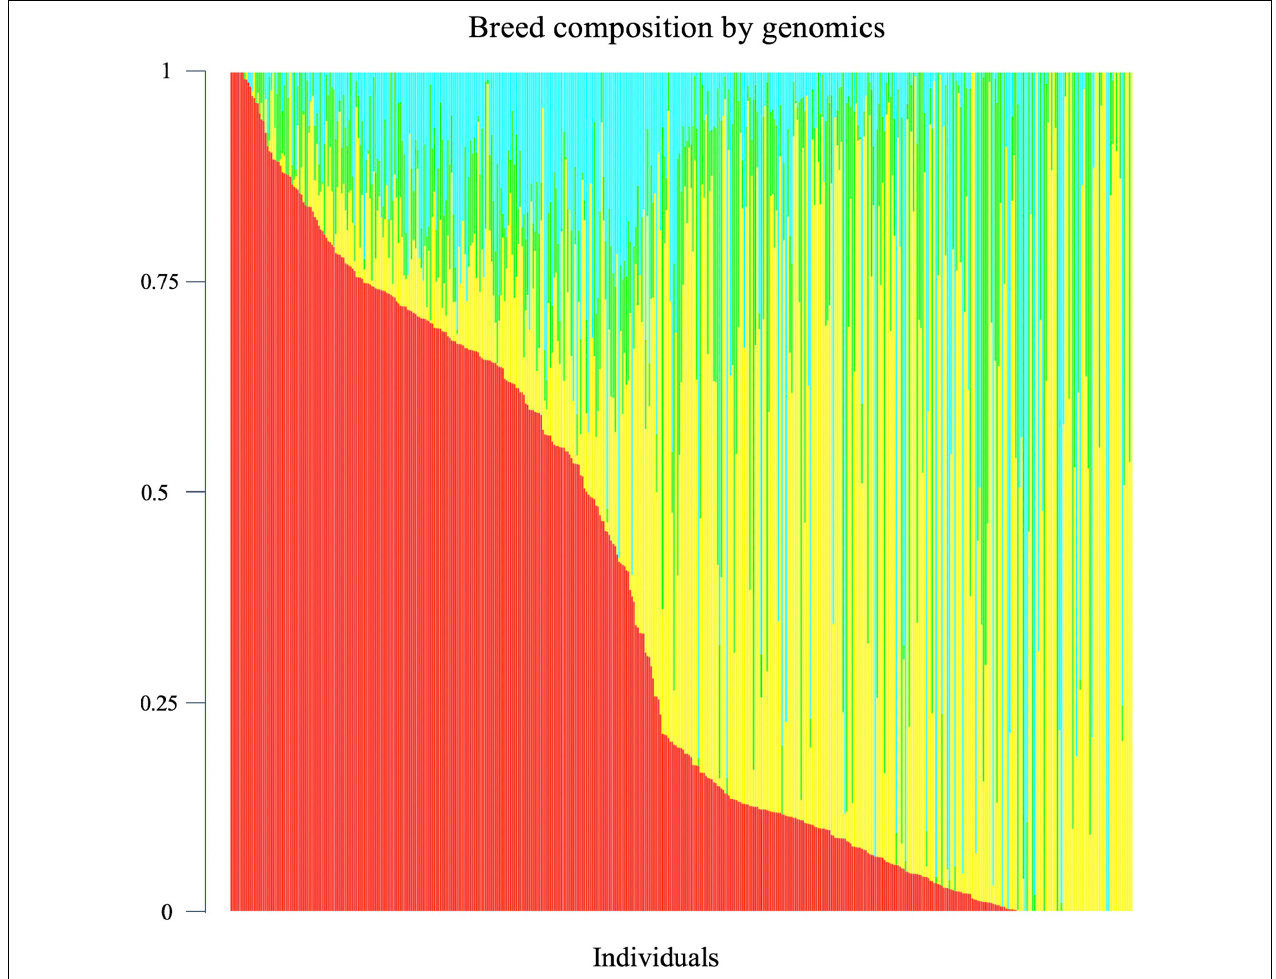
FIGURE 1 | Distribution of predicted genomic breed composition of crossbred beef cattle population ( n = 475). Beefbooster is red, Angus is yellow, Hereford is green, Charolais is blue.